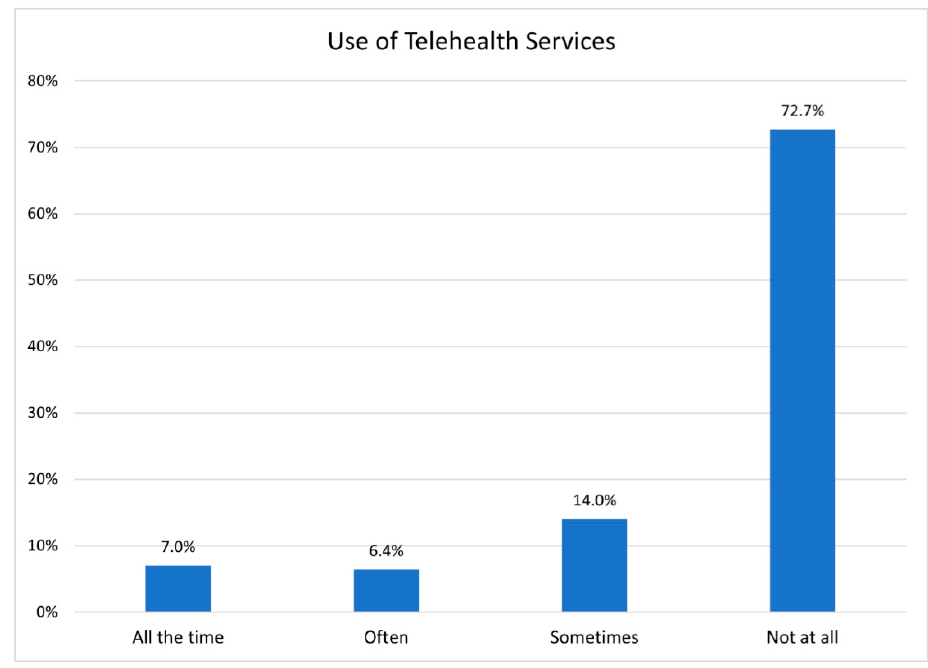
Figure 6. Use of Telehealth Services.